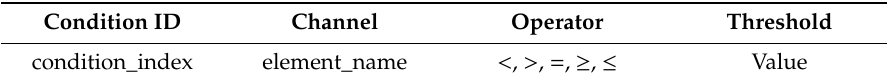
Table 6. Format of a first-order alarm condition [16].